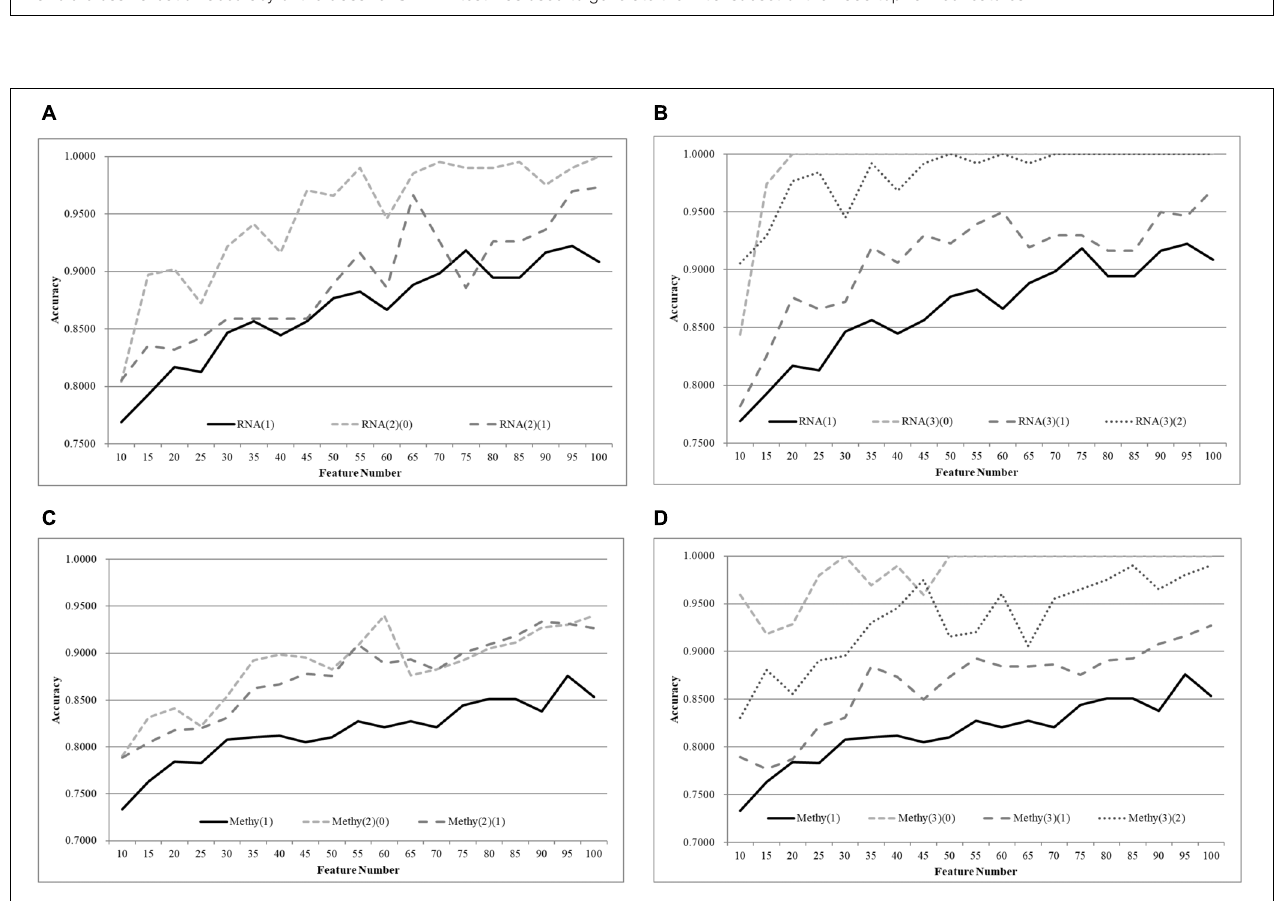
FIGURE 5 | Comparison of early-stage breast cancer detection models with different age groups based on both transcriptome and methylome data. Transcriptomes of the patients were split into (A) two groups and (B) three groups with equally-sized age ranges. The methylomes were split into (C) two groups and (D) three groups in the same way. The horizontal axis shows the numbers of features chosen by TriVote and the vertical axis shows the 10-fold cross-validation accuracy of the classifier SVM. F -test was used to generate the initial subset of the 1000 top-ranked features.